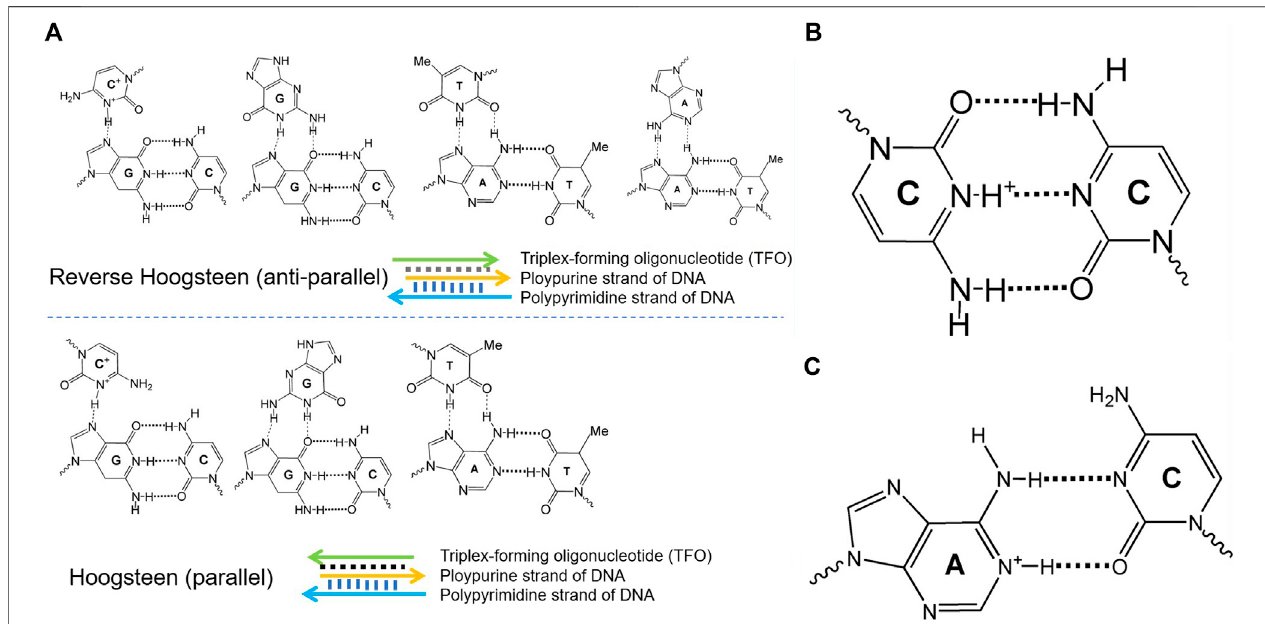
FIGURE1| DifferentconformationalDNAstructurecon fi gurations. (A) Differentcon fi gurationsoftheparallelandantiparalleltriplexDNA. (B) ThekeyelementC + -C in the i-motif DNA. (C) The protonation center of A + -C in the pH-dependent DNA motif.